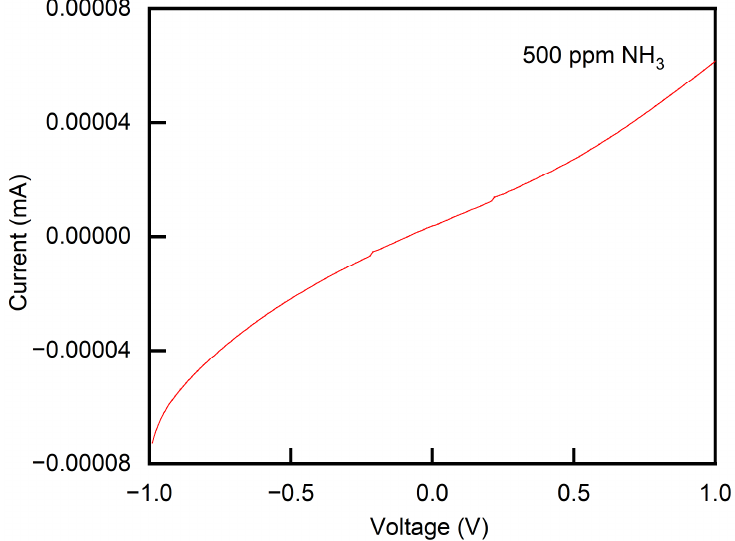
Figure 9. I-V characteristic curve of the layered heterostructured sensor composed of 2H-MoTe 2 film and PANI film when exposed to exposed to a 500 ppm concentration of NH 3 gas.